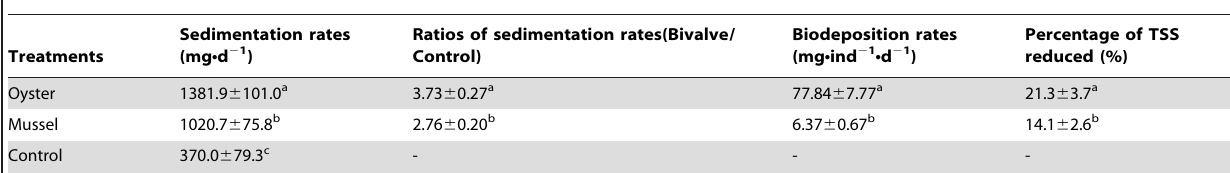
Table 2. Biological filter-removing rates of suspended particles in aquaculture wastewater by experimental bivalves.